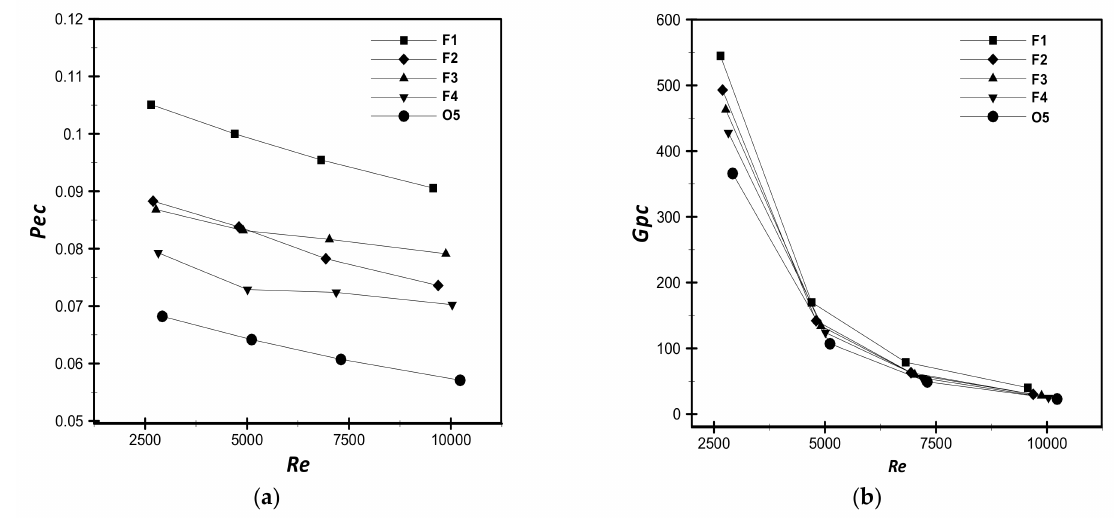
Figure 13. Influence of flat tube shapes and Reynolds number: ( a ) performance evaluation criterion and ( b ) global performance